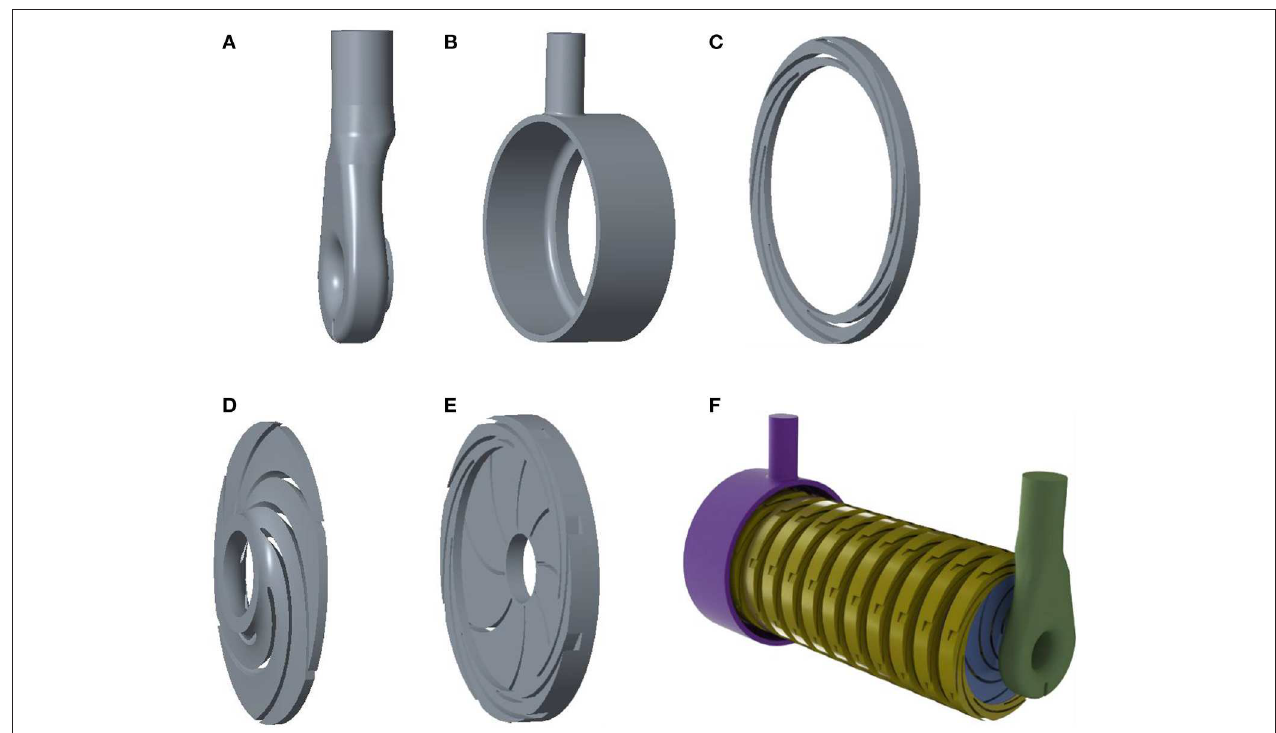
FIGURE 2 | Fluid domain of multistage centrifugal pump. (A) Suction chamber, (B) pump casing, (C) final guide vane, (D) impeller, (F) radial guide vane, and (G) multistage centrifugal pump integral flow domain.